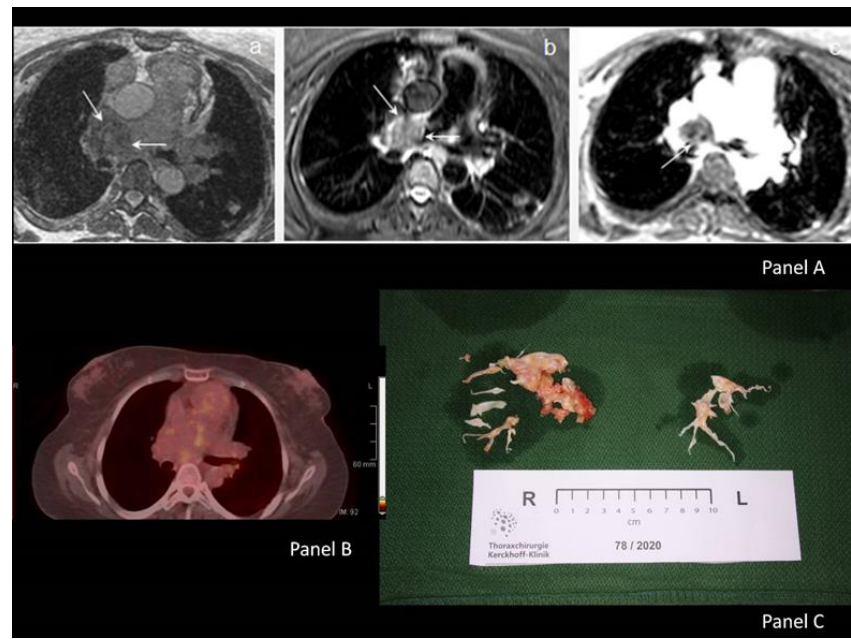
Figure 1. ( Panel A ) In MRA, the lesion expanded beyond the margins of the vessel wall having: a low signal similar to that of the muscles (T1WI) ( a ), an heterogeneous high signal intensity (T2W2) with fat saturation ( b ) and finally progressive increase in the enhancement of the lesion during post GD injection (instance from MR perfusion imaging) ( c ); ( Panel B ) In PET, excessive tissue emanating from the RPA and extending towards the hilum and the sub-carinal region with inhomogeneous FDG distribution (SUVmax: 3.1); ( Panel C ) Surgical specimen with fresh clots along with multiple partially organized adherent thrombi.